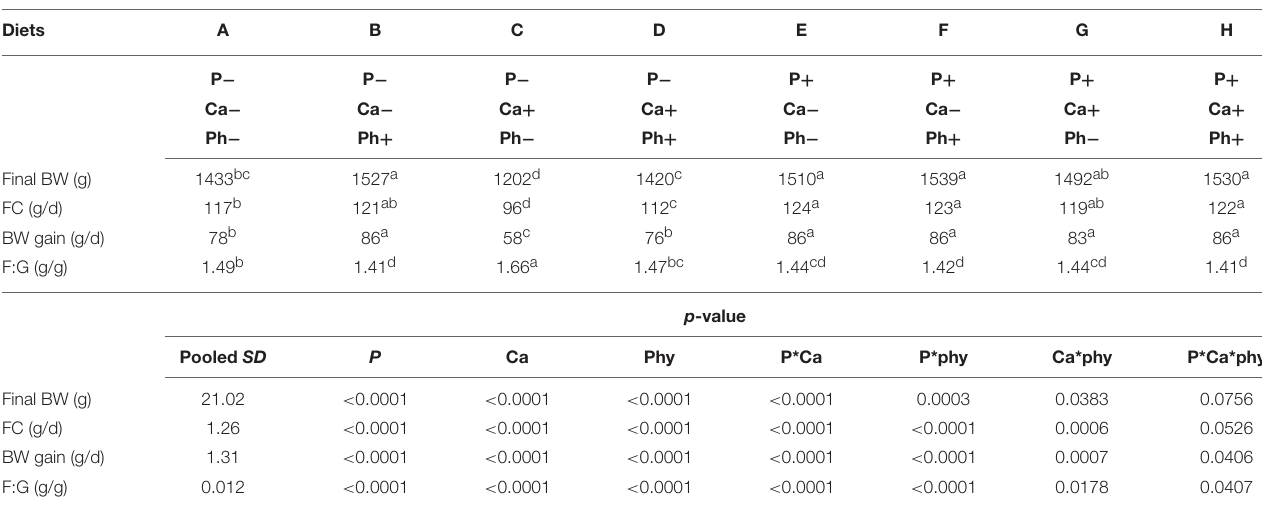
TABLE 2 | Broiler chickens performance data between day 15 and 26 for the eight dietary treatments.